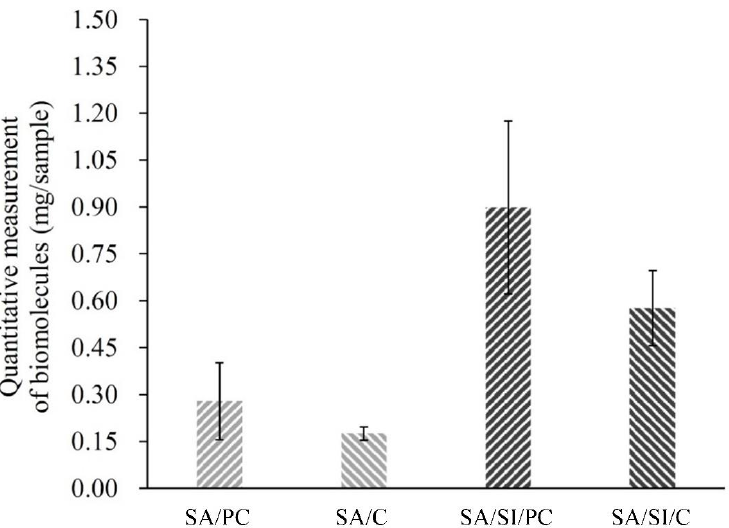
Figure 5. Bioactive molecule grafting weights of different surface-modified PEEK surfaces ( n = 6).